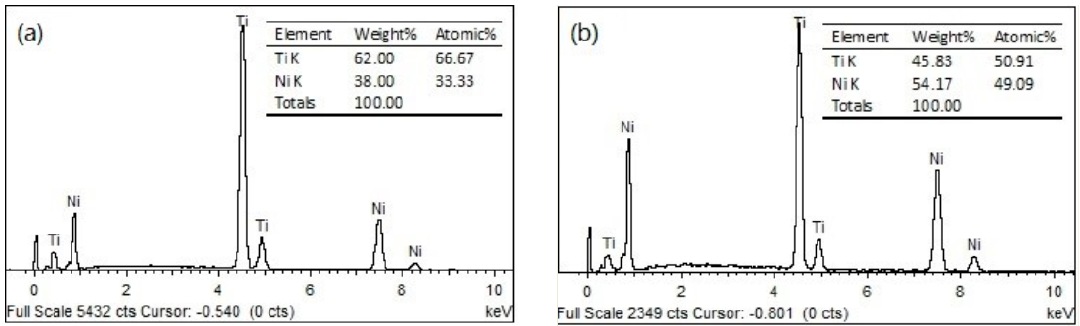
Figure 2. Normalized pixel amounts of precipitates in SEM images of Ni 50 − x Ti 50 La x alloys.